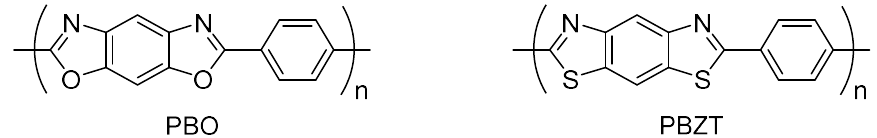
Figure 2. Chemical structures of inherently flame-retardant polymers (polyphenylene-benzobisoxazole (PBO) and polyphenylene-benzobisthiazole (PBZT)).